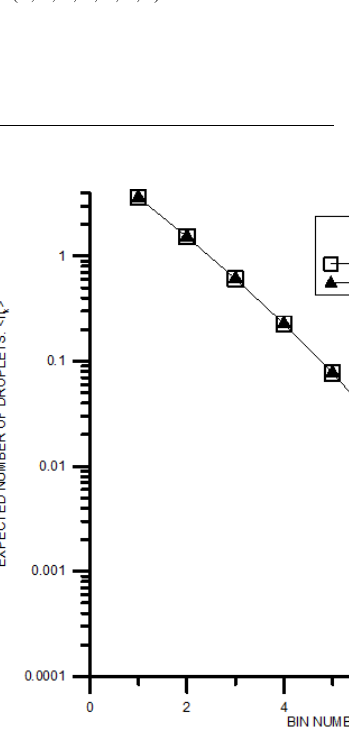
Figure 4. Same as Fig. 3 but for the constant kernel K(i,j) = 1 . 2 × 10 − 4 cm − 3 s − 1